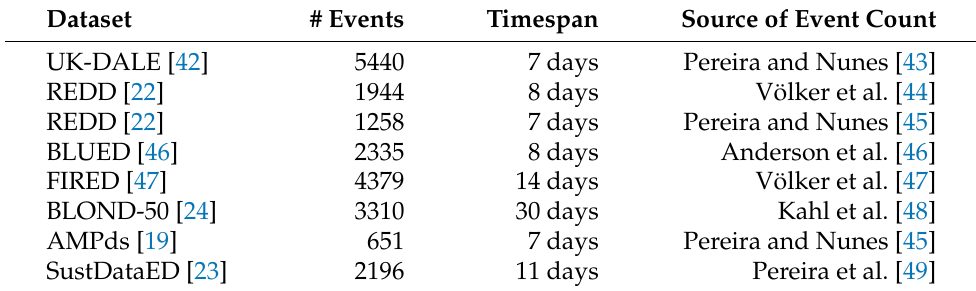
Table 2. Summary of the number of events detected in publicly released electricity